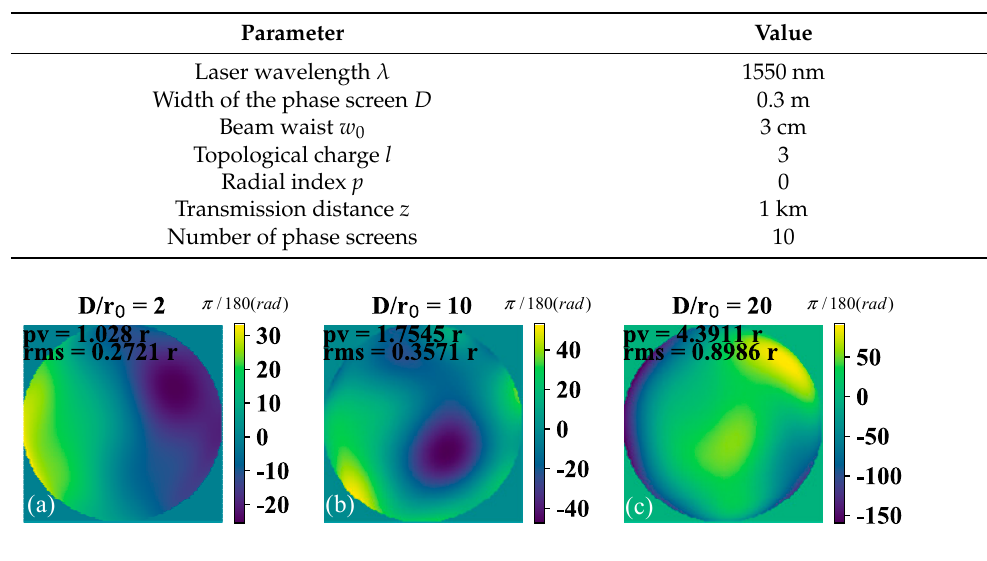
Figure 4. Turbulentphasedistribution: ( a )weakturbulence; ( b )moderateturbulence; ( c )strongturbulence. Figure 4. Turbulent phase distribution: ( a ) weak turbulence; ( b ) moderate turbulence; ( c ) strong turbulence.